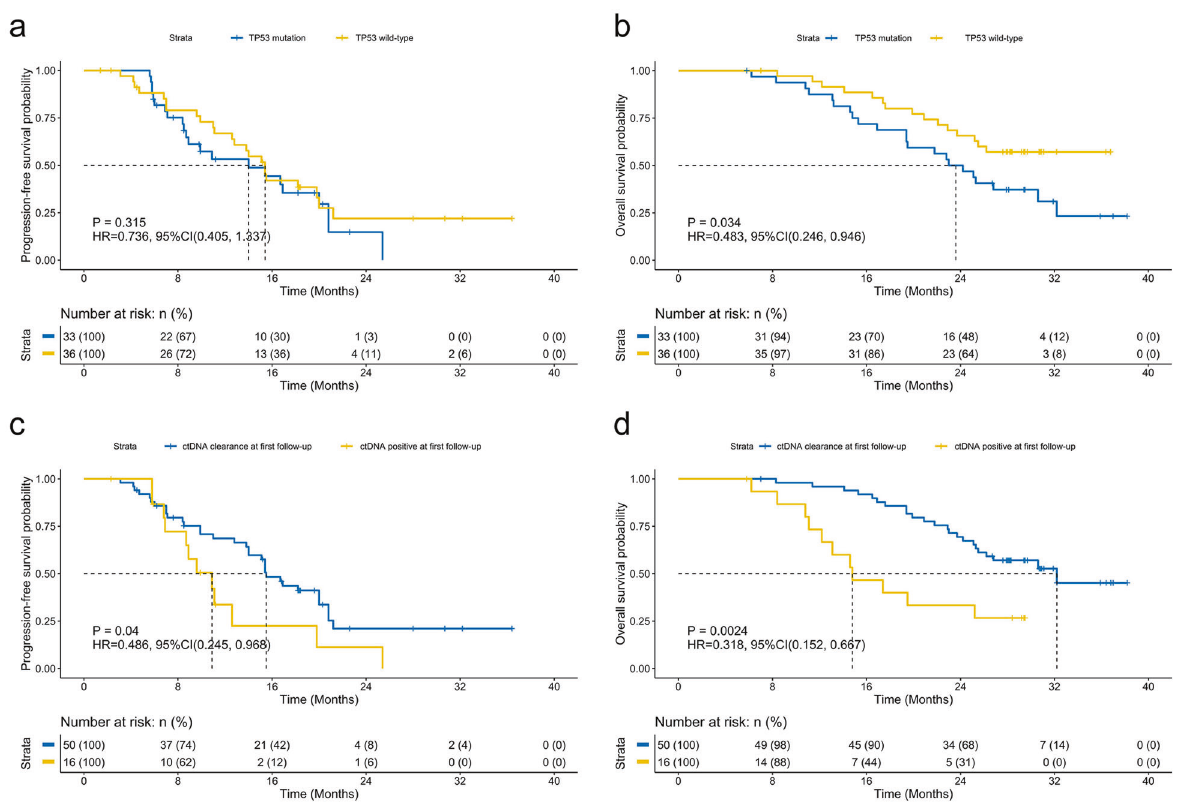
Fig. 2 Kaplan – Meier curves comparing the PFS ( a ) and OS ( b ) of patients with advanced EGFR – mutant non-small-cell lung cancer who had concomitant TP53 mutations as compared to patients who had wild-type TP53 . Patients who experienced ctDNA clearance at fi rst follow-up had signi fi cantly longer survival outcomes. Kaplan – Meier curves comparing the PFS ( c ) and OS ( d ) of patients with EGFR – mutant non-small- cell lung cancer who experienced ctDNA clearance at fi rst follow-up compared with patients who had detectable mutations